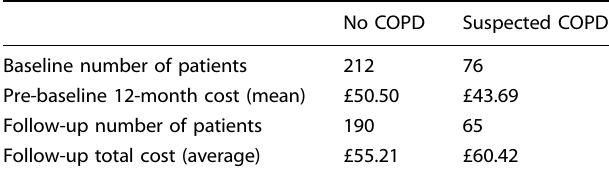
Table 2. Summary of patient